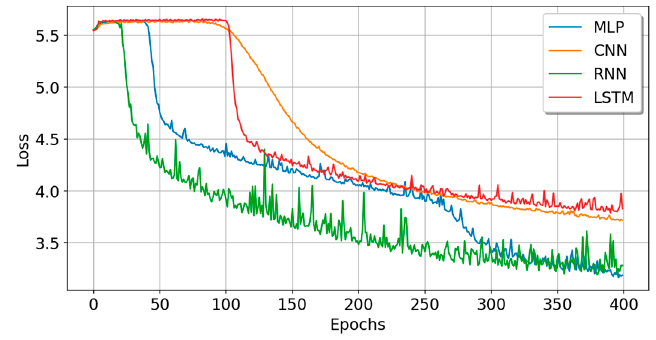
Figure 11. Attack accuracy of four models.